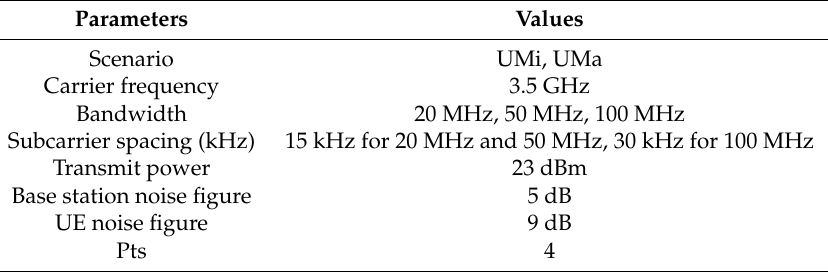
Table 2. The parameters of the simulation system.